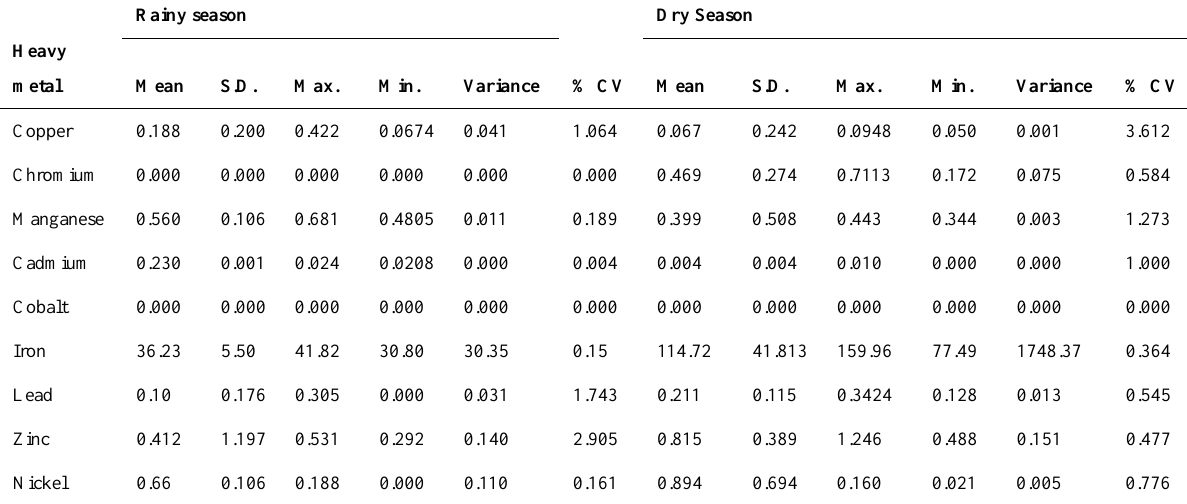
Descriptive Statistics of Seasonal Heavy Metal